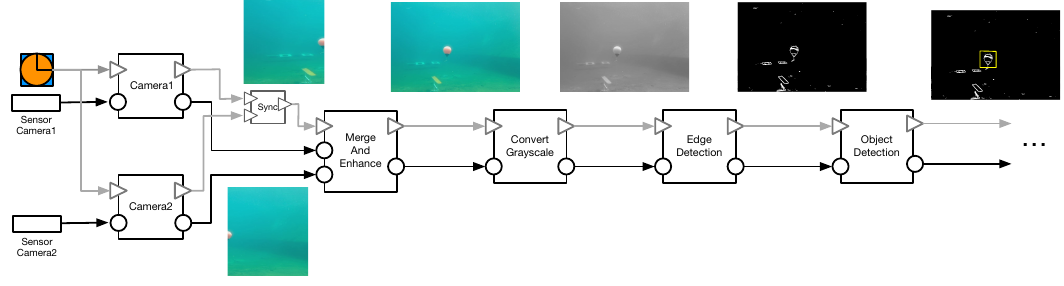
Figure 1. The vision system of an underwater